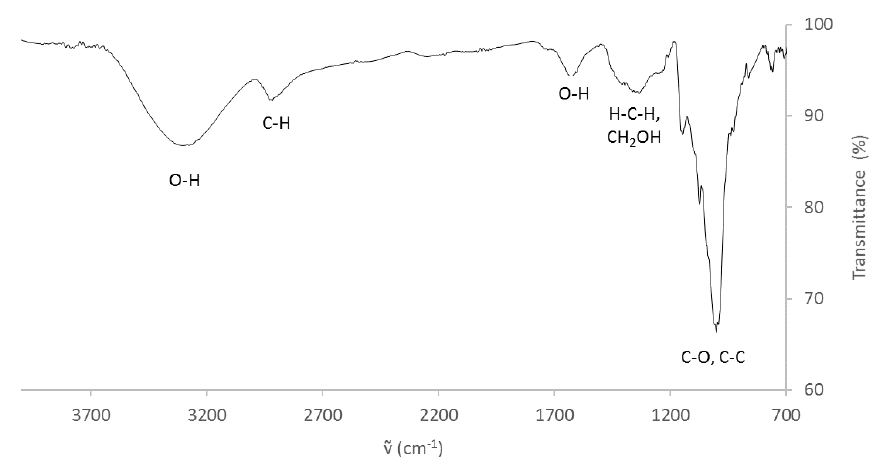
Figure 2. ATR FT-IR of sweet potato residue.